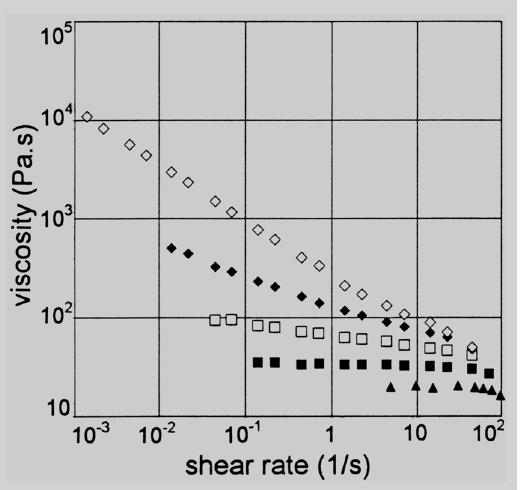
Figure 1 (right): Viscosity curves of suspensions with the silicone oil M 20000 and different concentrations of Cab-o-sil TS 720 ( ‡ 1%, · 3%, Ï 5%, Ì 7%) and silicone oil M20’000 ( Ú